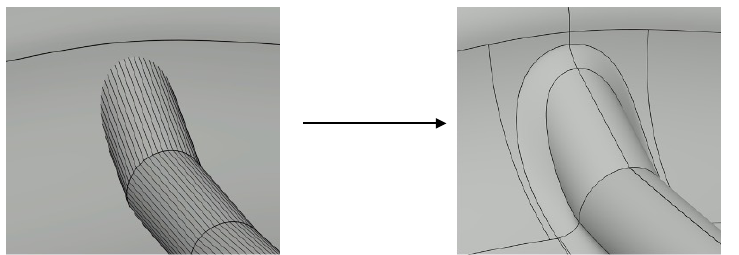
Figure 2. Smoothing the attachment of strut tubes and canopy: wing geometry before ( left ) and after ( right ) the filleting. In the original CAD geometry the strut tubes are attached to the leading edge tube. Because the connection of the leading edge tube with the canopy is also smoothed by a fillet [20], the strut tubes connect to this fillet surface and not anymore to the original leading edge tube.